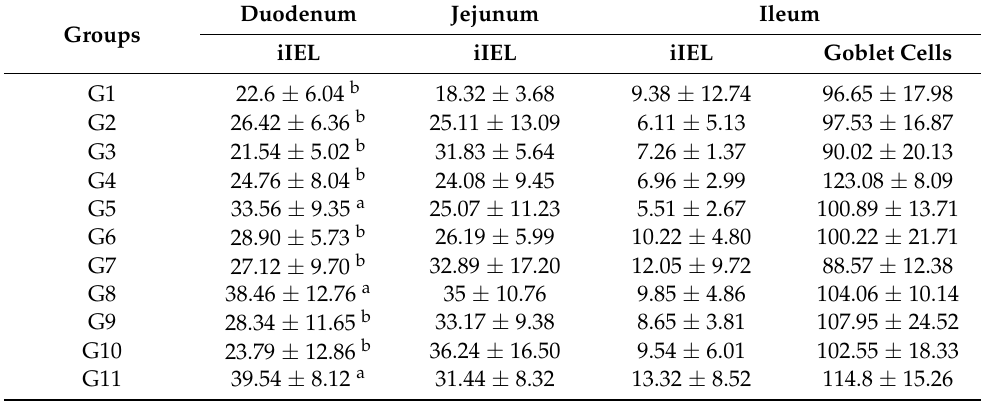
Table 4. Means of small intestine intraepithelial lymphocyte (iIEL) count and ileal goblet cell count. Groups